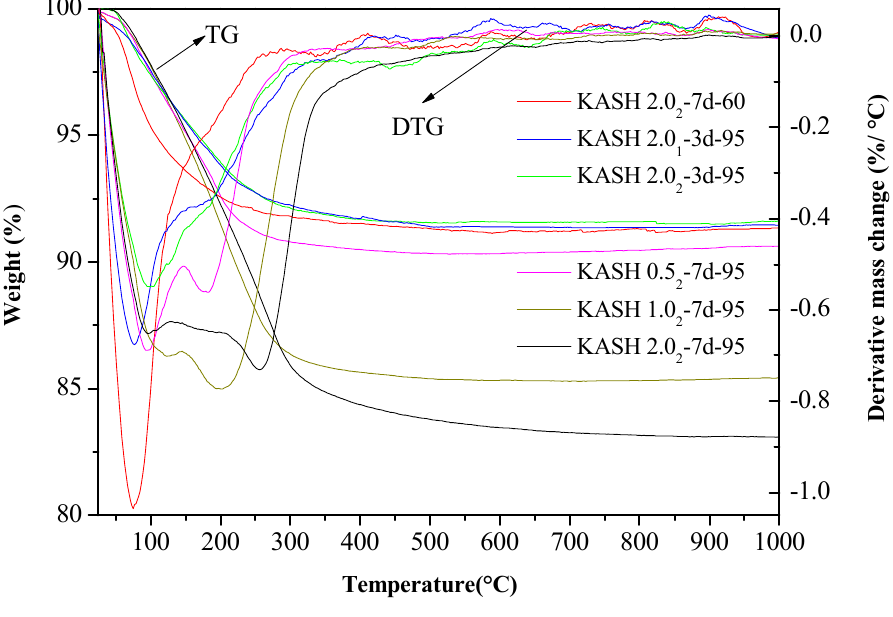
Figure 2. TG / DTG curves of K-A-S-H Figure 2. TG/DTG curves of K-A-S-H samples.